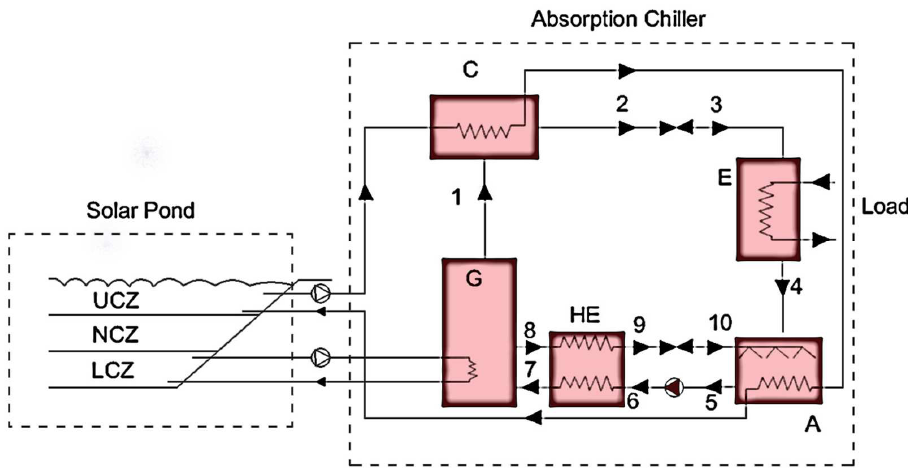
Figure 1. A schematic of the system: a solar pond coupled with an absorption chiller for cooling applications. A: Absorber, C: Condenser, E: Evaporator, G: Generator, HE: solution heat exchanger.